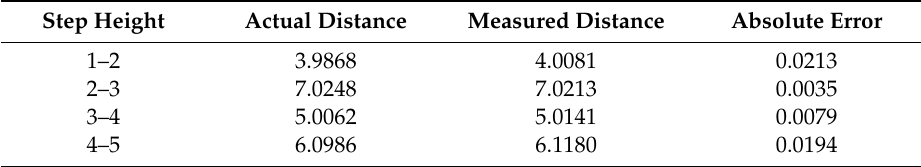
Figure 7. Phase maps of the artificial mirror step. ( a )–( c ) Wrapped phase of the step; ( d ) Unwrapped phase of the step.